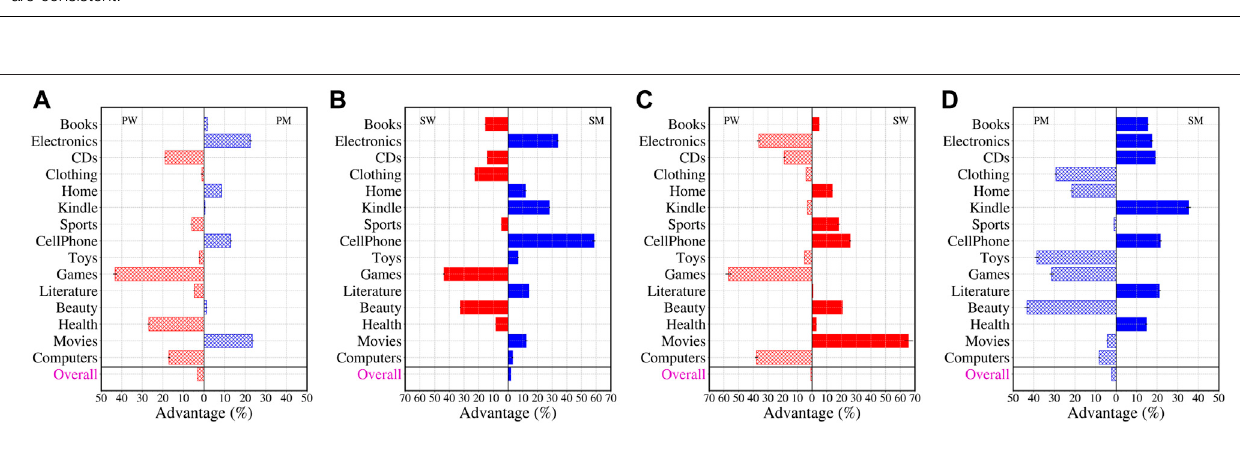
FIGURE 6 | The effects of gender signaling and performance. We show the advantage gained by one group over the other across different categories when comparing the paired-treatment groups - (A) performing women and performing men (PW-PM), (B) signaling women, signaling men (SW-SM), (C) performing women, signaling women(PW-SW) and (D) performingmen, signaling men (PM-SM). Notablyreviewerswithuncleargender signalsintheir username but performing aswomen receive higher scores than signaling women in categories such as Electronics, Games or Computers while the same is true for reviewers performing as men with unclear gender signals in categories like Clothing, Beauty or Toys. However, overall , there seems to be no effect of gender signaling on the perceived helpfulness of a reviewingeneral.Notethatineachcasetheadvantagereportediscalculatedasmeanoverbootstrapsamples.Wealsoreportthestandarderrorofthemeanswhichare very low for all the cases across four paired-treatment